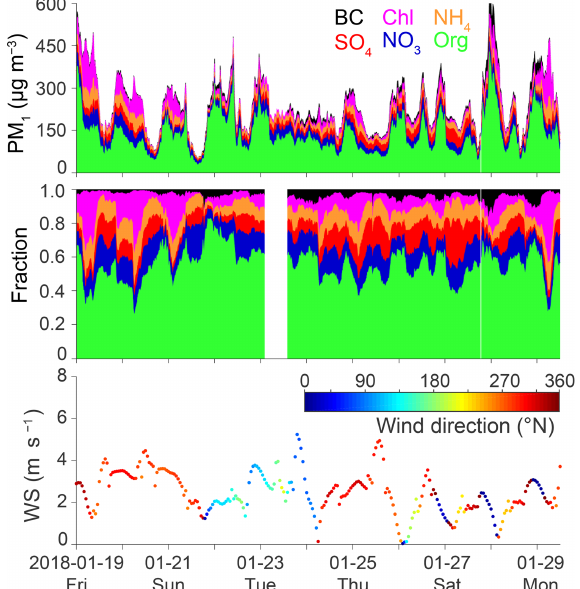
Figure 7. Time series of PM 1 species (Org, Chl, NH 4 , NO 3 , SO 4 , and BC) – stacked absolute concentrations and fraction of PM 1 – along with wind speed and wind direction for a period with high chloride concentrations.